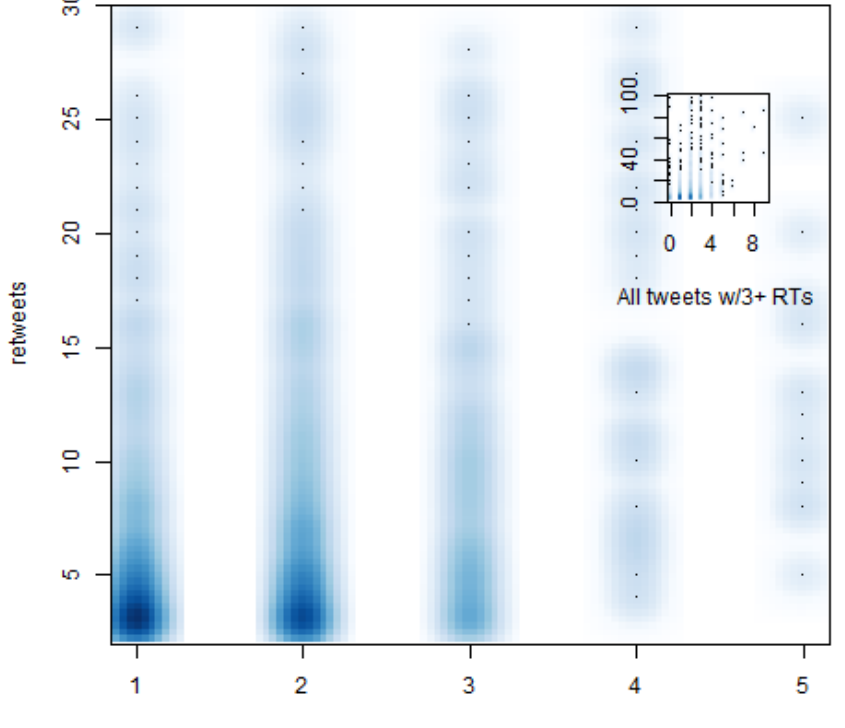
Figure 3. Density plot of social distance travelled by retweeted tweets by number of retweets (10-day